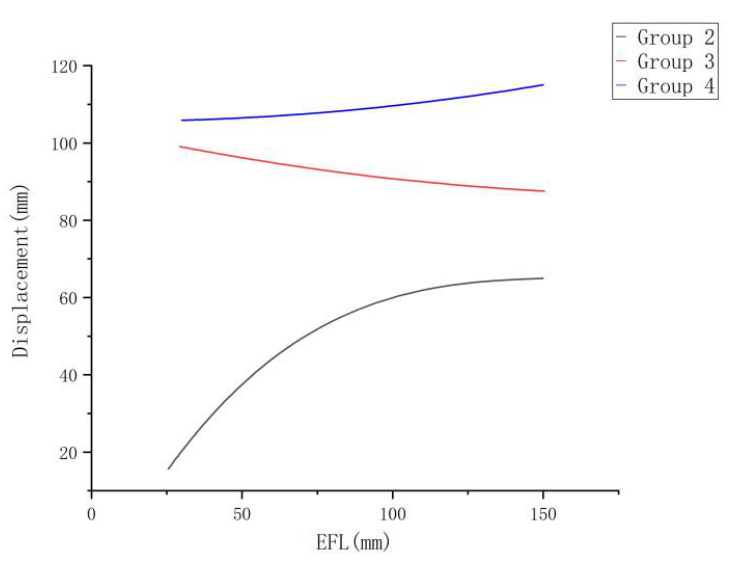
Figure 6. Zoom Figure 6. Zoom curves.